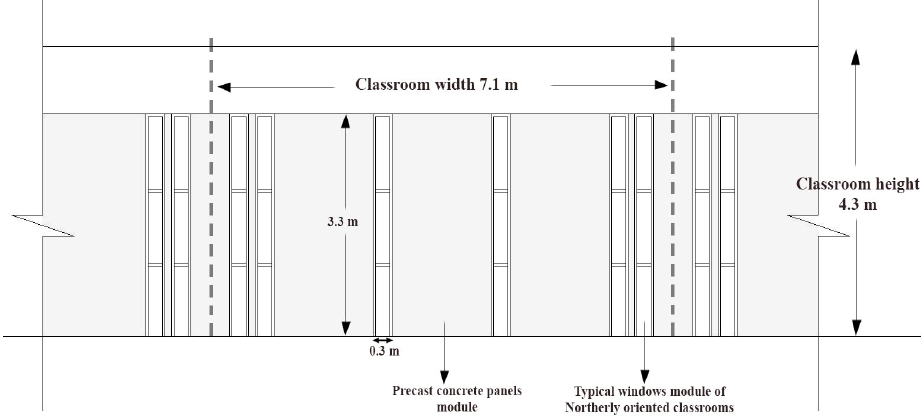
Figure 3. Northern elevation of a typical classroom at JUST showing the windows’ shape and location.